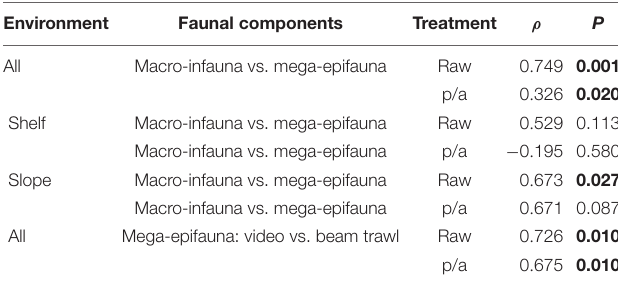
TABLE 4 | Patterns of community composition change between all sampling sites across all environments, and within the Shelf and Slope only.